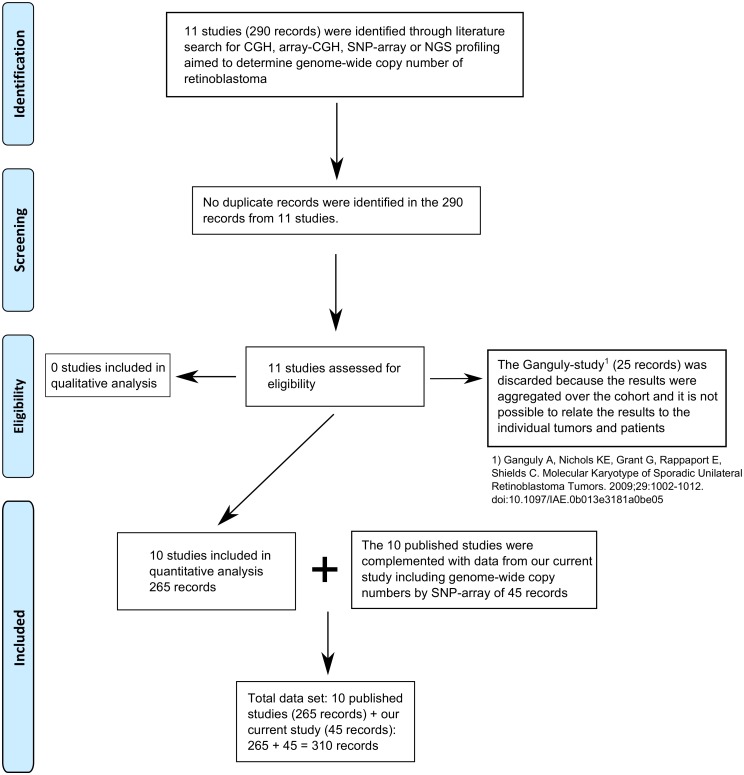
PRISMA flow chart.Searching google scholar for “retinoblastoma”, “copy number”, “(a)CGH”, and “SNP-array”, 11 studies were identified that performed genome-wide profiling of retinoblastoma adding up to 290 samples. No duplicates samples were identified. For the Ganguly study [14], copy number results could not be linked to individual tumors and therefore this study, including 25 samples was discarded. The remaining 265 samples were all included in quantitative analysis and were complemented with 45 SNP-arrays from our current study, adding up to 310 samples.